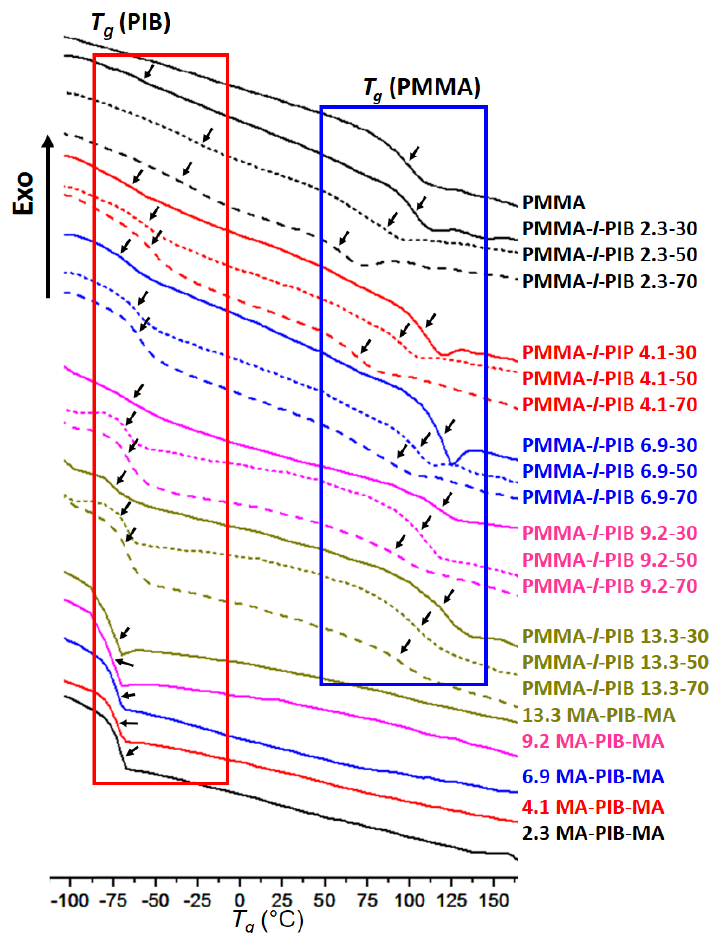
Figure 1. Glass transition temperatures ( T g ) of the poly(methyl methacrylate)- l -polyisobutylene (PMMA- l -PIB) conetworks as a function of composition (the lines represent the T g of the methacrylate-telechelic polyisobutylenes (MA-PIB-MA) macromolecular cross-linkers and the poly(methyl methacrylate) (PMMA) homopolymer, and the inflection points as T g values are indicated by arrows).